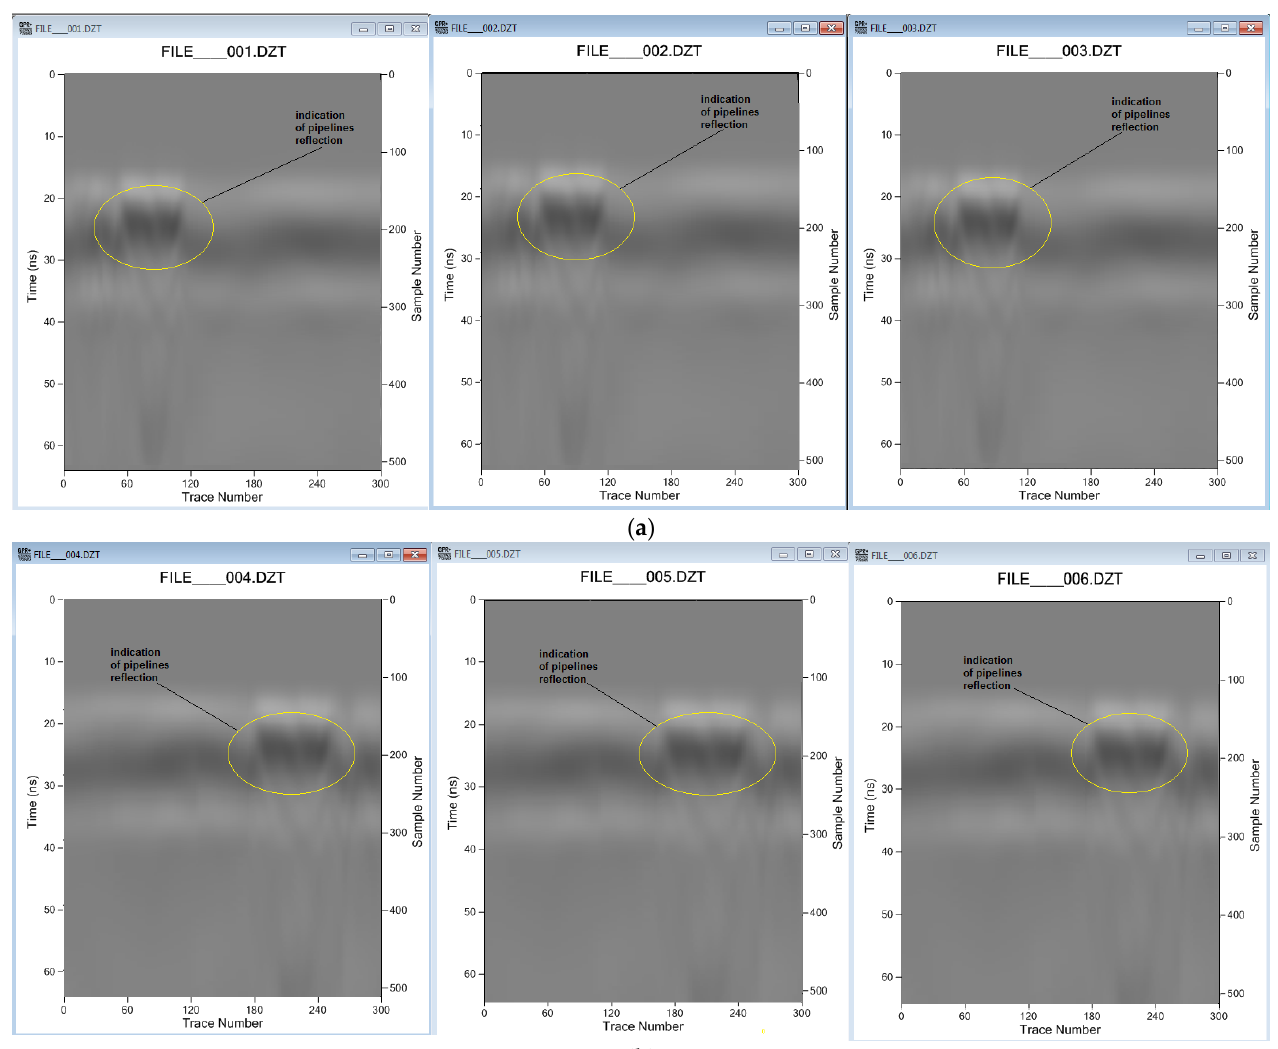
Figure 5. Raw data imaging at scan of zone transversal on drainage pipes (see Figure 3a): ( a ) File_001_002_003 forward scan, ( b ) File_004_005_006 backward scan.